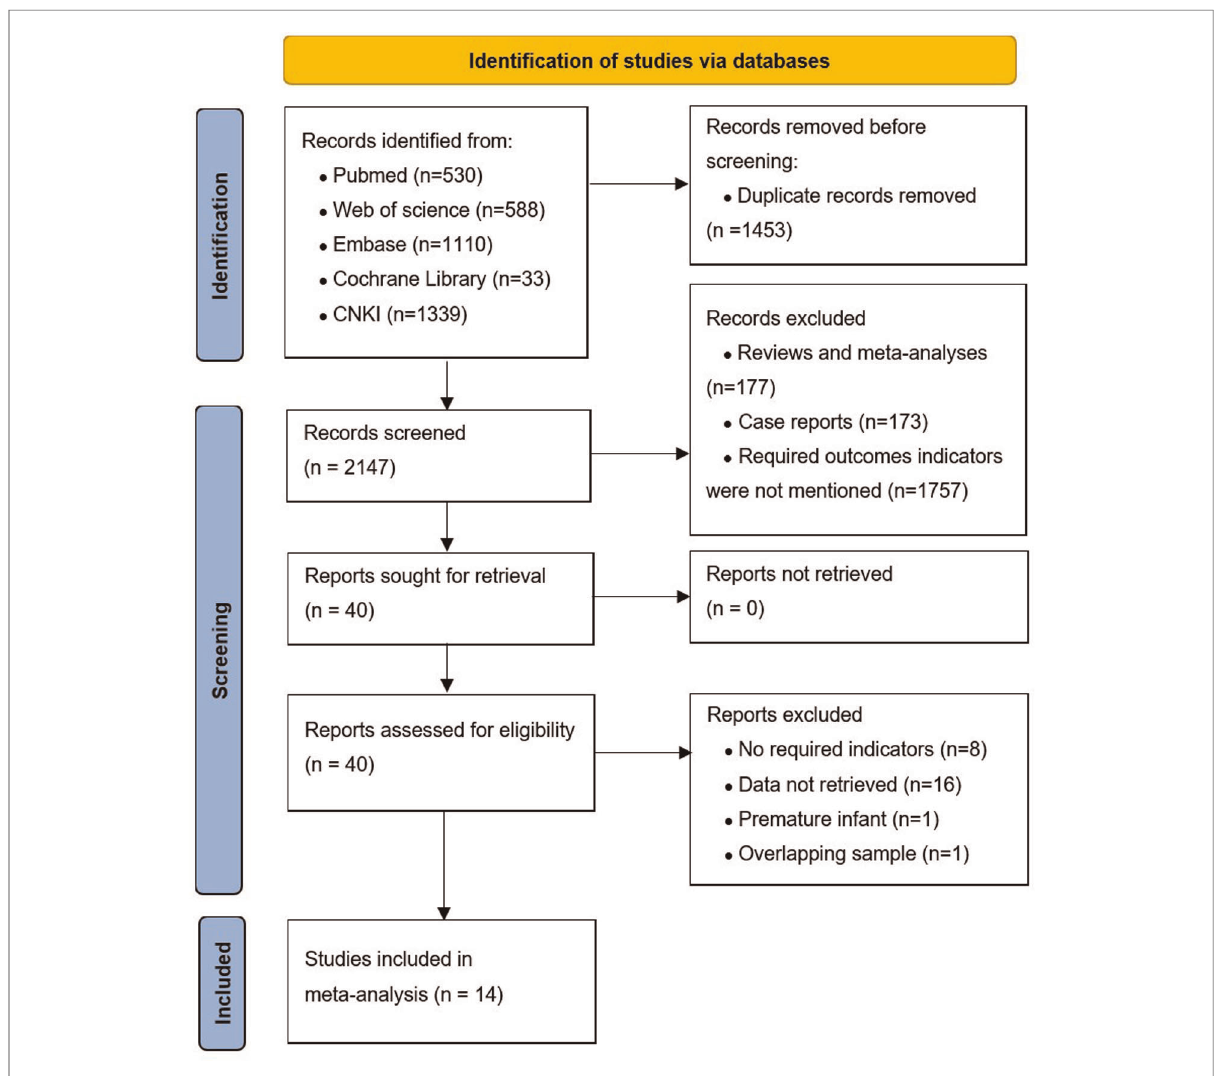
FIGURE 1 Flowchart of literature search and study